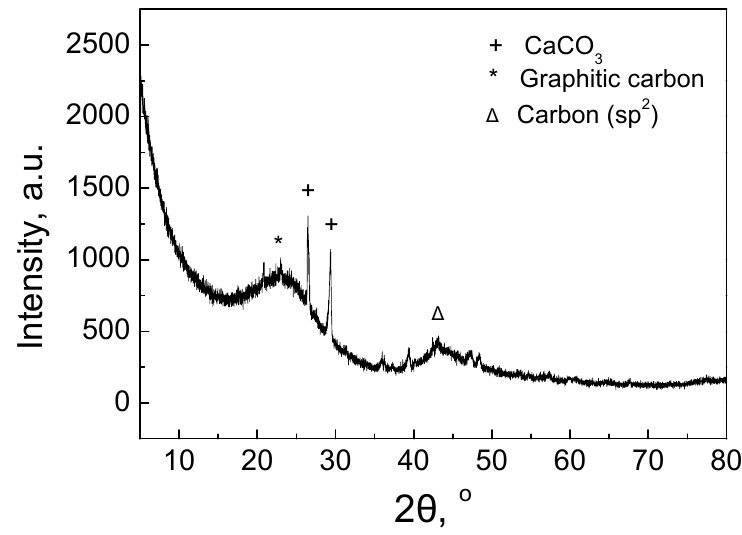
Figure 2. XRD pattern of the biochar.